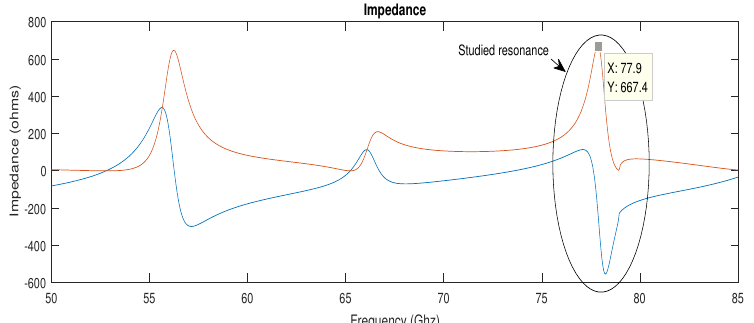
Figure 4. Impedance variation against frequency band around 77 GHz: obtained by the MoM GEC method.